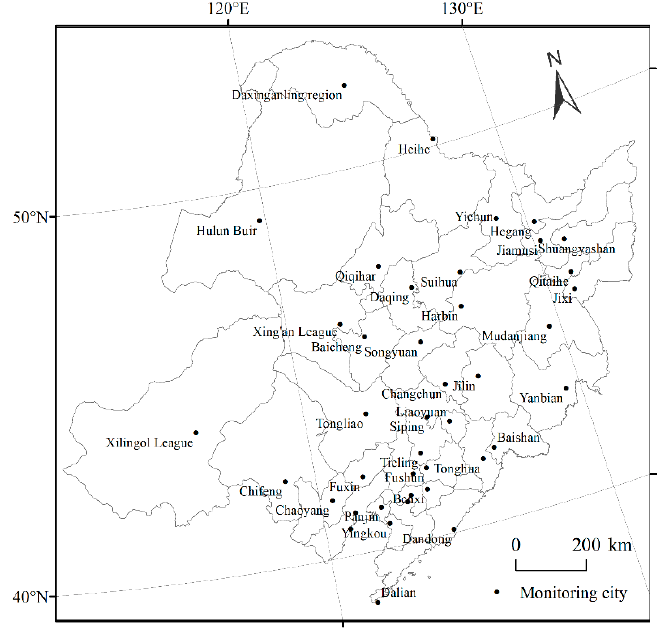
Figure 1. Sites of state ‐ controlled monitoring stations in Northeast China.